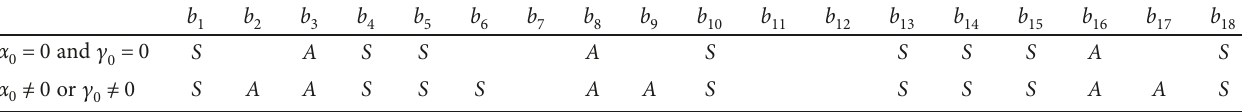
Table 2: Mass coe ffi cients of Model A and Model C for CUS and